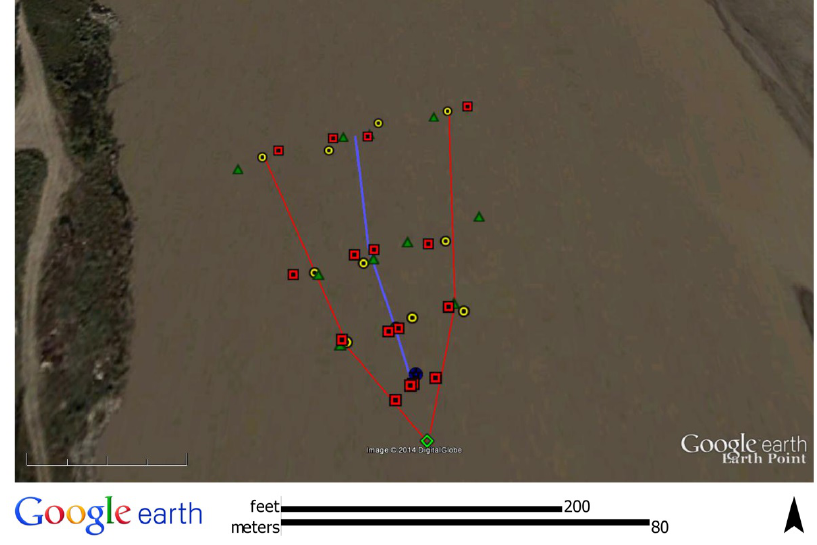
Figure 5. Locations of significant rotation changes detected in all transects. Red squares indicate buoy only; green triangles denote DDD minimum opening; yellow circles show the DDD maximum opening. Lime squares and blue circles indicate buoy and DDD locations, respectively. Red and light blue lines indicate the average positions of the wakes. The flow direction is from bottom to top.